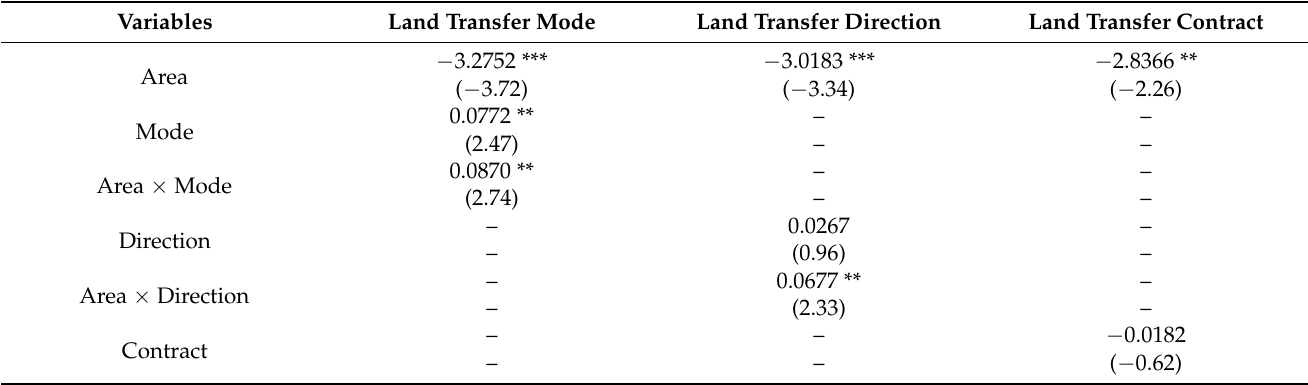
Table 7. Estimation results of moderating effect of land transfer mode, direction, and